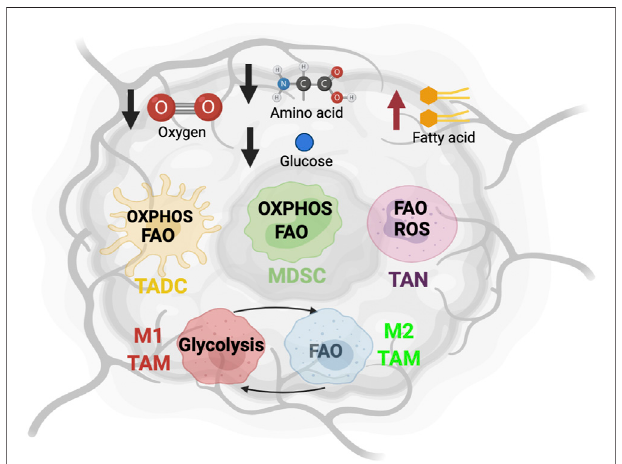
FIGURE 2 | The metabolic features of MDSCs. The tumor-in fi ltrating MDSCs upregulate glycolysis pathway to support their expansion, while promoting amino acid and fatty acid metabolism to support their immunosuppressive function. “ ↑ ” indicates “ increase. ” HK, hexokinase; PFK1, Phosphofructokinase 1; PKM2, Pyruvate kinase isozymes M1/M2; NMDAR, N-methyl- D -aspartate receptor; LDHA, Lactate dehydrogenase A; GLS, Glutaminase; CPT1A, Carnitine Palmitoyltransferase 1A; HADHA, Hydroxyacyl-CoA Dehydrogenase Trifunctional Multienzyme Complex Subunit Alpha; ACADM, Acyl-CoA Dehydrogenase Medium